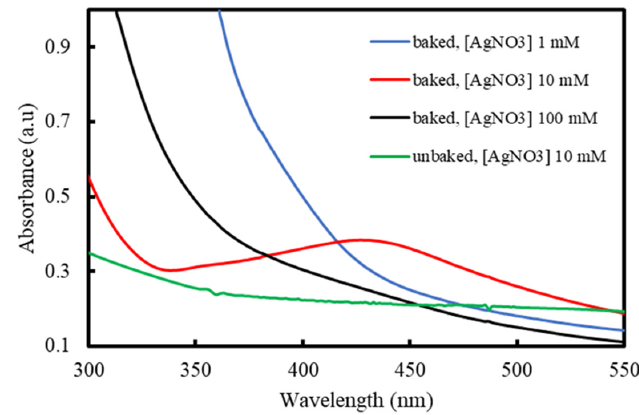
Figure 2. UV-Vis spectra of the colloidal samples.